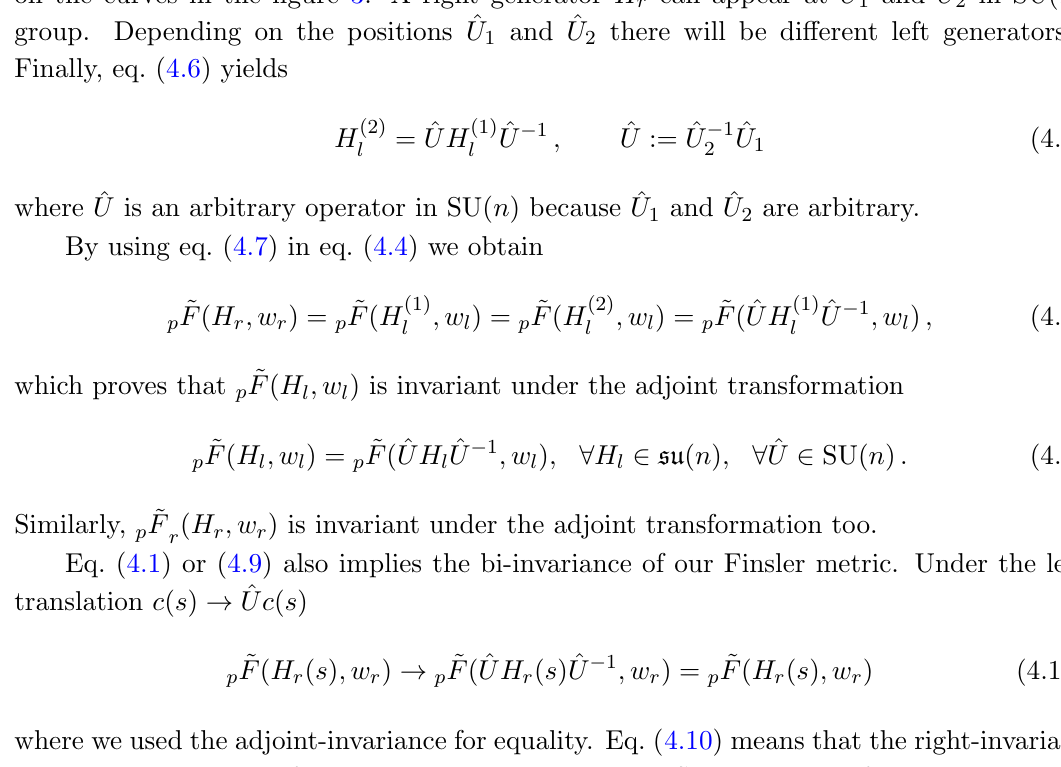
^ U (cid:0) 1 with ^ U = ^ U (cid:0) 1 ^ U = ^ UH (1) 1 . 2 l l can appear at ^ U and ^ U in SU( n ) r 1 2 and ^ U there will be di(cid:11)erent left generators. 3 1 2